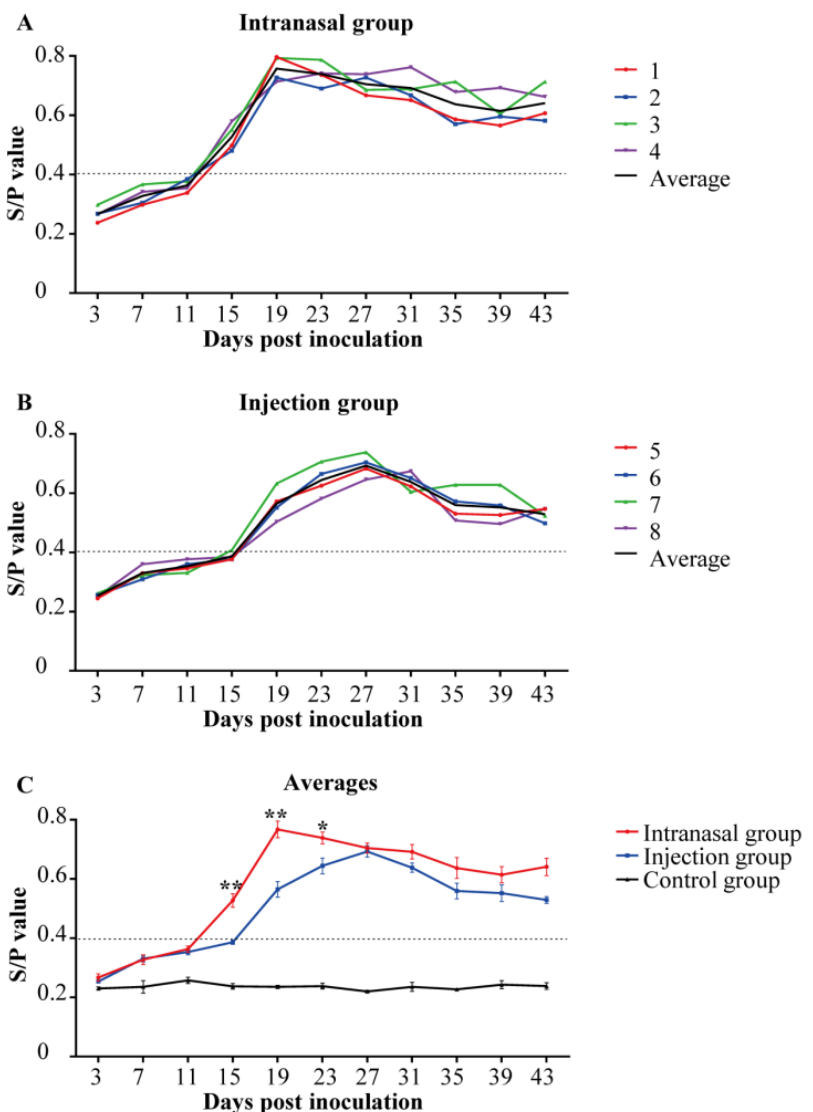
Figure 4. Anti-PRRSV saliva SIgA levels. The anti-PRRSV saliva SIgA levels were quantified using ELISA in piglets ( n = 4 in each group) to assess the anti-PRRSV antibody response. Saliva samples collected at 0 dpi were served as the negative control. The cut-off for positivity was 0.4. Piglets in the control group were SIgA-negative throughout the study. ( A , B ): Colored lines represent the individual animals, and black lines represent the mean value of each group. Numbers (1–9) represent the individual pig numbers. ( A ) Anti-PRRSV saliva SIgA levels in the intranasal group. ( B ) Anti-PRRSV saliva SIgA levels in the injection group. ( C ) The averages of saliva SIgA levels within each group. The graph illustrates the mean ± SEM. Statistical differences were determined using the t -test (* p < 0.05; ** p < 0.01). Comparisons were between the Intranasal and the Injection groups.